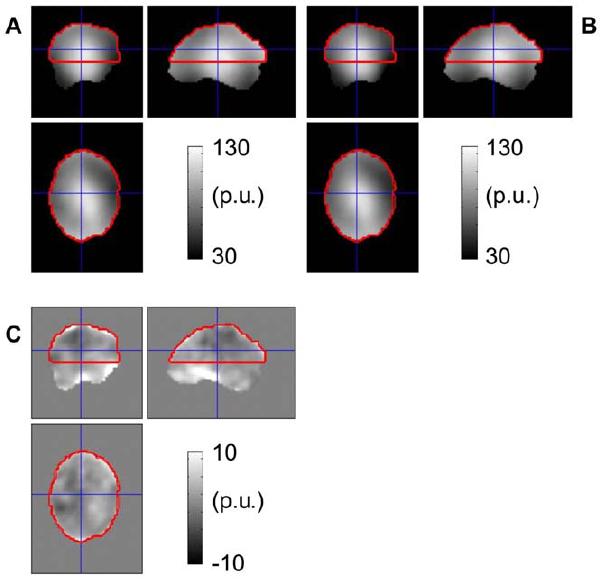
Figure 1. Comparison of 3D EPI and AFI methods. B 1 + maps acquired with the 3D EPI (a) and AFI (b) methods. Difference between the B 1 + maps acquired using the two methods (c). The red contour lines represent the superior part of the brain, used as a region of interest for quantitative comparison of both methods. Note that due to imperfect spoiling, the AFI method is expected to underperform in regions with low B 1 + amplitudes such as the temporal lobes.